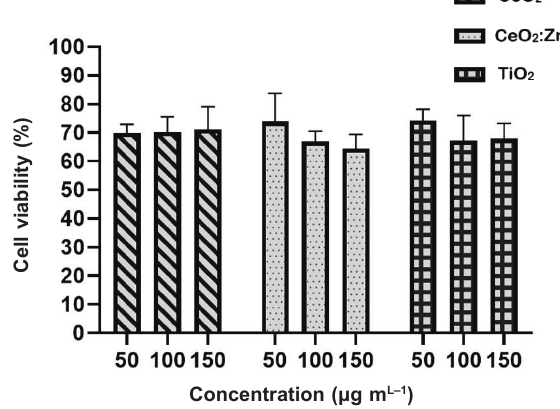
Fig. 6 – HaCaT cells viability (%) after 24 h of incubation at 37 °C treated with ceria, zinc-doped ceria, and titania nanopar- ticles as determined by the MTT assay. The values denote the mean ± S.D. (n =